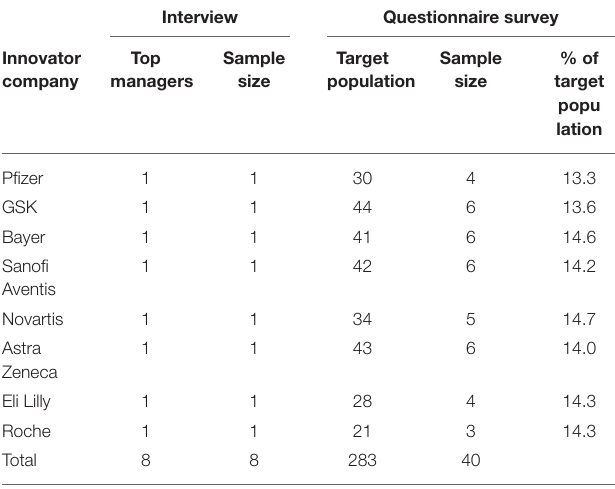
TABLE 1 | Target population and sample frame.